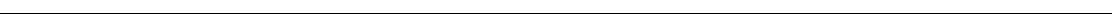
Fig. 5 Endothelial Dll1 regulates macrophage maturation and arteriogenesis. a Analysis of cell populations by fl ow cytometry in ischemic muscle of induced endothelial Dll1 mutant mice ( Dll1 i Δ EC ) and control mice. n = 8 mice/group, error bars represent s.e.m. * p < 0.05 by two way ANOVA with Bonferroni multiple comparison test. b Gene expression analysis of macrophages sorted from d3 ischemic muscle. n = 3 independent experiments, error bars represent s.e.m. ** p < 0.01, * p < 0.05, Student ’ s unpaired t -test. c – f Rescue of endothelial Dll1 de fi ciency after HLI by transfer of ischemic macrophages. On d1 after HLI, indicated groups received intramuscular limb injections of 5 × 10e5 macrophages isolated from d3 ischemic muscle (MF) or Ly6C hi monocytes isolated from spleen (Mo) of wt mice, or received control treatment. c Foot perfusion by laser Doppler perfusion measurement immediately after induction of HLI (0) and during follow up. n = 5/7/7/7 mice/group, error bars represent s.e.m. *** p < 0.001 by two way ANOVA and Bonferroni post test. d Quanti fi cation of inner circumference and wall area, and representative H&E stained images of collateral arteries d14. Scale bar = 50 μ m. n = 7 mice/ group, error bars represent s.e.m. *** p < 0.001 vs control by one way ANOVA and Dunnett ’ s multiple comparison test. e Representative SMA-stained immuno fl uorescence of muscle sections, Scale bar 100 μ m (left) and quanti fi cation of arterial branches (SMA + ) per section d14, n = 5 mice/group, error bars represent s.e.m. *** p < 0.001 vs control by one way ANOVA and Dunnett ’ s multiple comparison test. f Representative H&E stained muscle sections. Scale bar = 50 μ m (left) and quanti fi cation of ghost cells and regenerating muscle fi bers (right) at d14, n = 5 mice/group, error bars represent s.e.m. *** p < 0.001 vs control by one way ANOVA and Dunnett ’ s multiple comparison